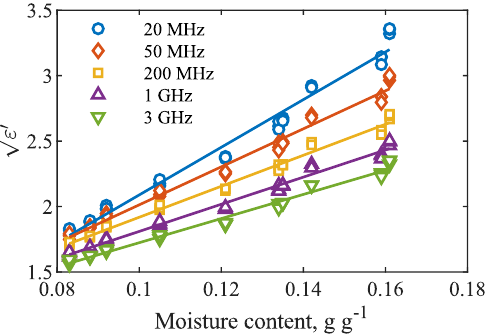
√ ε (cid:48) at selected